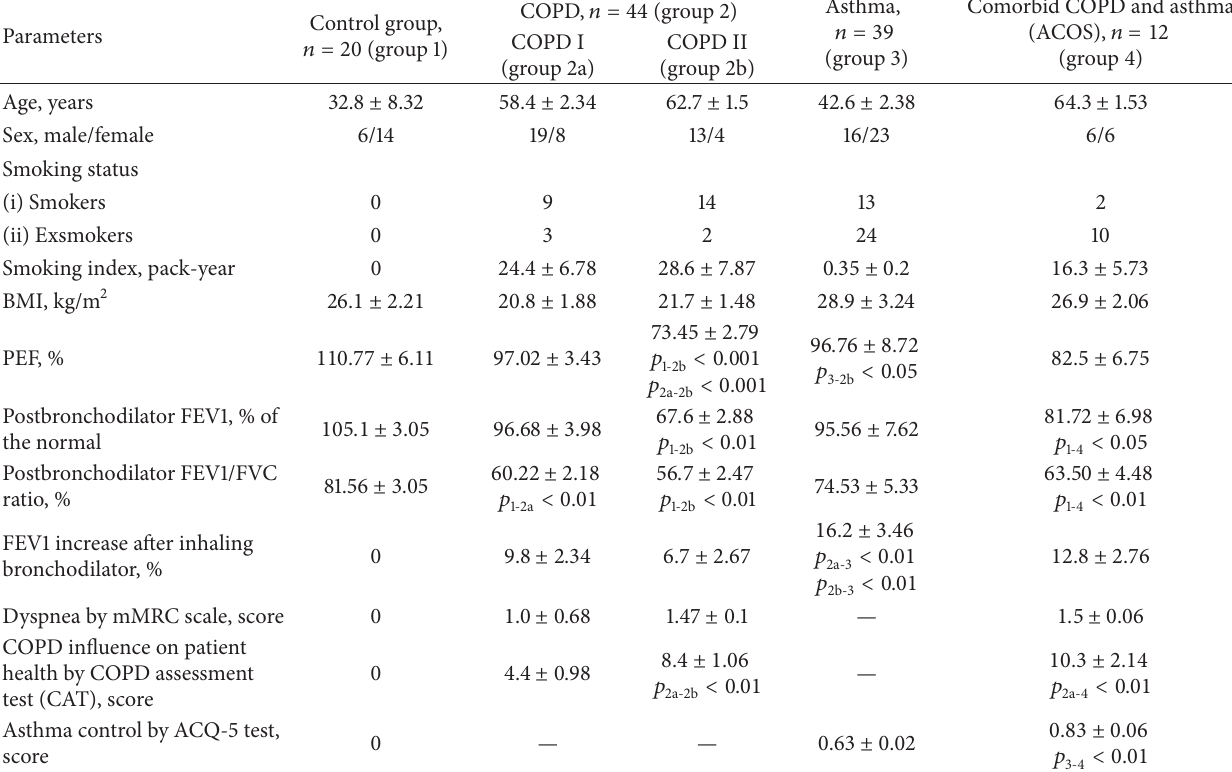
Table 1: The clinical and functional parameters of patients included in